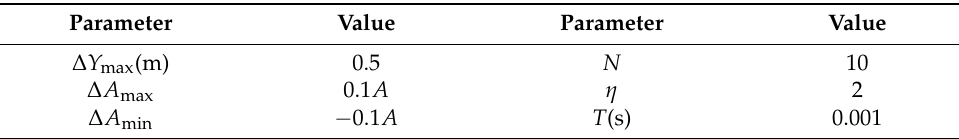
Figure 4. Simulation platform for algorithm verification. Table 2. Controller parameters for simulation.